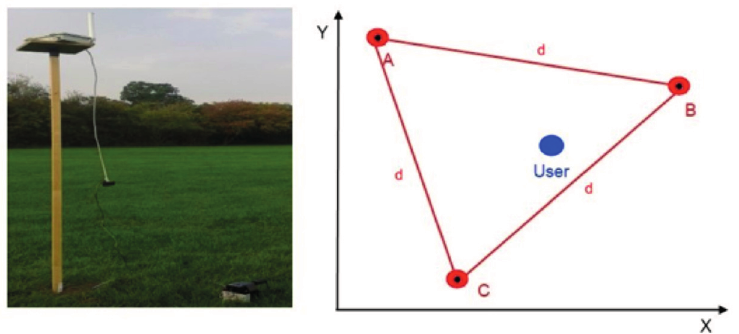
Figure 4. Wireless router on a pole (simulating an autonomous vehicle) and the experimental